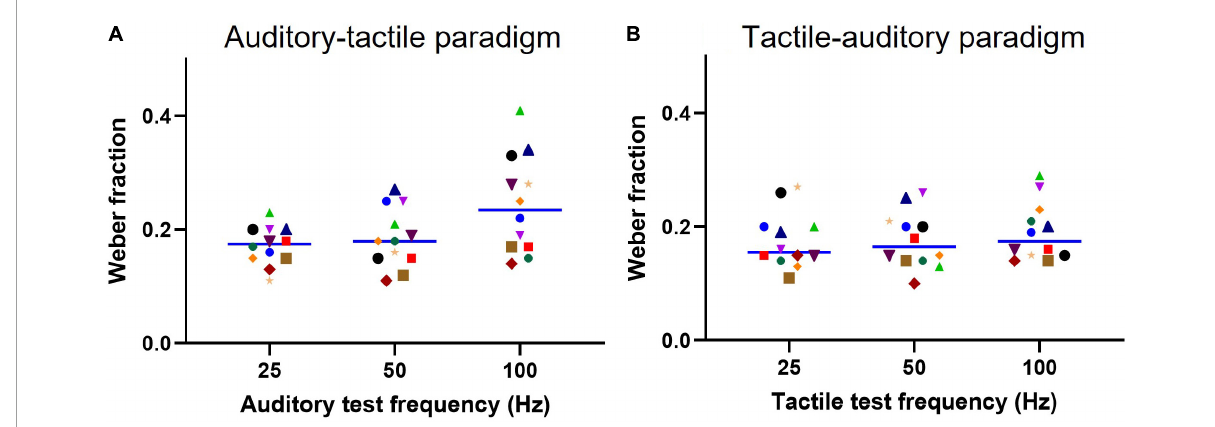
FIGURE4 Weber fractions for each test stimulus. (A) Individual subject Weber fractions for each auditory test frequency using tactile comparisons (Auditory-tactile paradigm). (B) Similarly, individual subject Weber fractions for tactile test conditions using auditory comparisons (tactile-auditory paradigm). A solid line indicates a median ( n = 12) Weber fraction value for a test